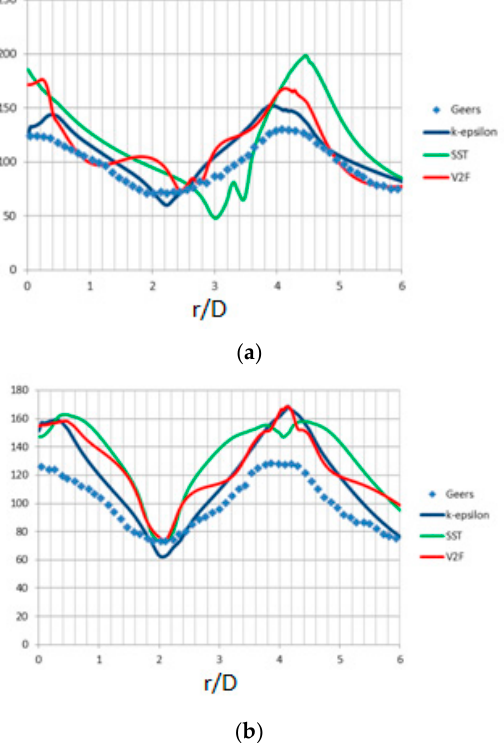
Figure 9. Experimental and numerical trends of the Nusselt number: (a) x/D = 0 and (b) x/D = 4. In Figure 10, the velocity contours at plane x/D = 0 from the numerical simulation (above) and the experimental data (below) are compared. A difference is observed at the jet axis. Compared to the experimental case, the numerical data have a lower speed decrease on the jet axis. This may further account for the overestimation of the heat exchange in the stagnation area.